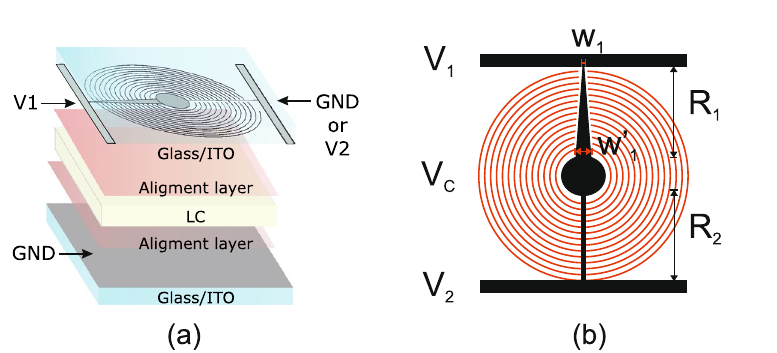
Figure 2. ( a ) Schematic depiction of the LC-tunable large-aperture lens and its various constituent parts. The top substrate shows the electrode configuration for the distribution of the applied voltage profile. ( b ) Detail of the top substrate electrode. The figure was generated using Inkscape software with version no. 1 and link https:// inksc ape. org/